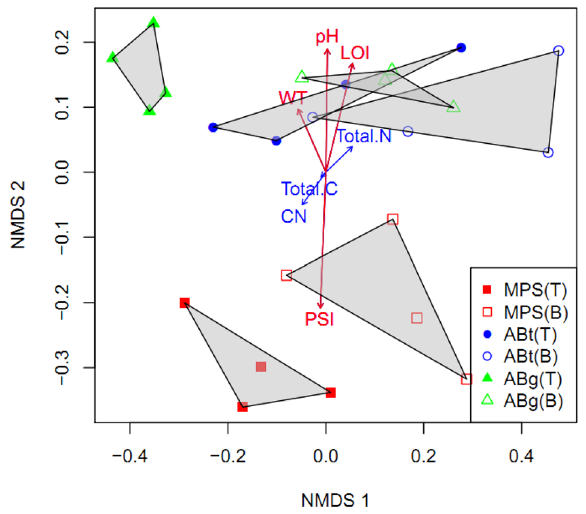
Figure 3. Non-metric multidimensional scaling (NMDS) analysis based on Bray–Curtis distant matrices of prokaryotic microbiota, forest types and soil depth. A vector overlay of the physicochemical variables is shown on the plot. Vectors shown in red color are the significantly correlated variables; PSI, pH, LOI and